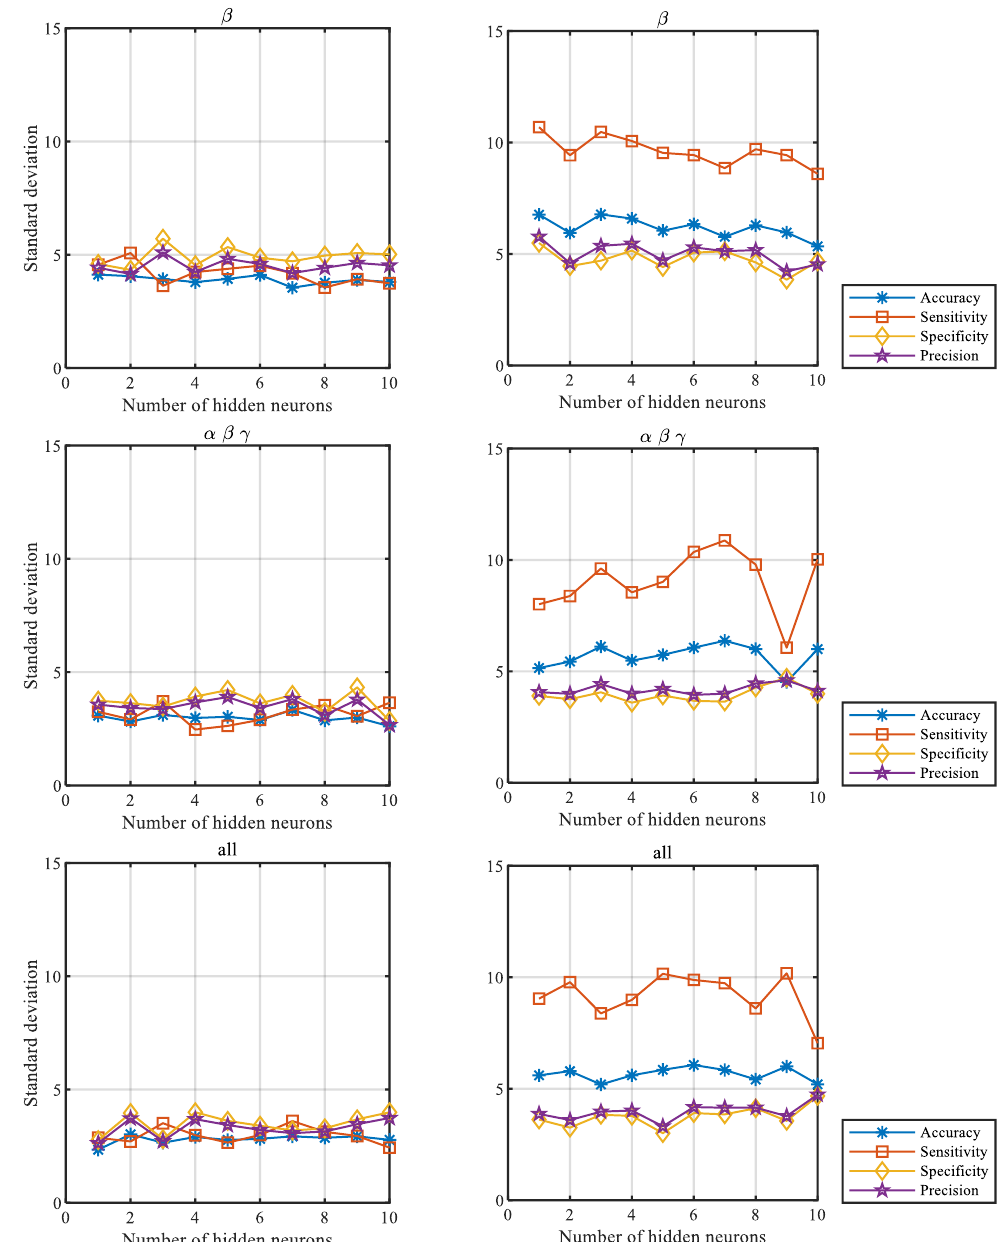
Figure 4. Standard deviations of network classification measures for selected frequency bands, where the training and testing feature set vectors were separated by different parts of the same sessions ( left , the first scenario) and by different sessions ( right , the second scenario).